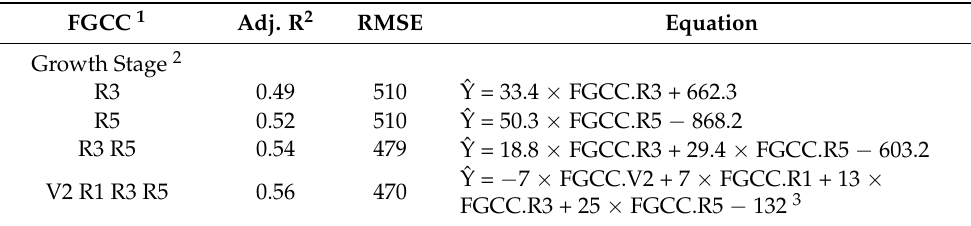
Table 7. Regression parameters using fractional green canopy cover measured at various growth stages throughout the growing season to predict yield at Casselton, Prosper, and Fargo, North Dakota, USA, in 2019 and